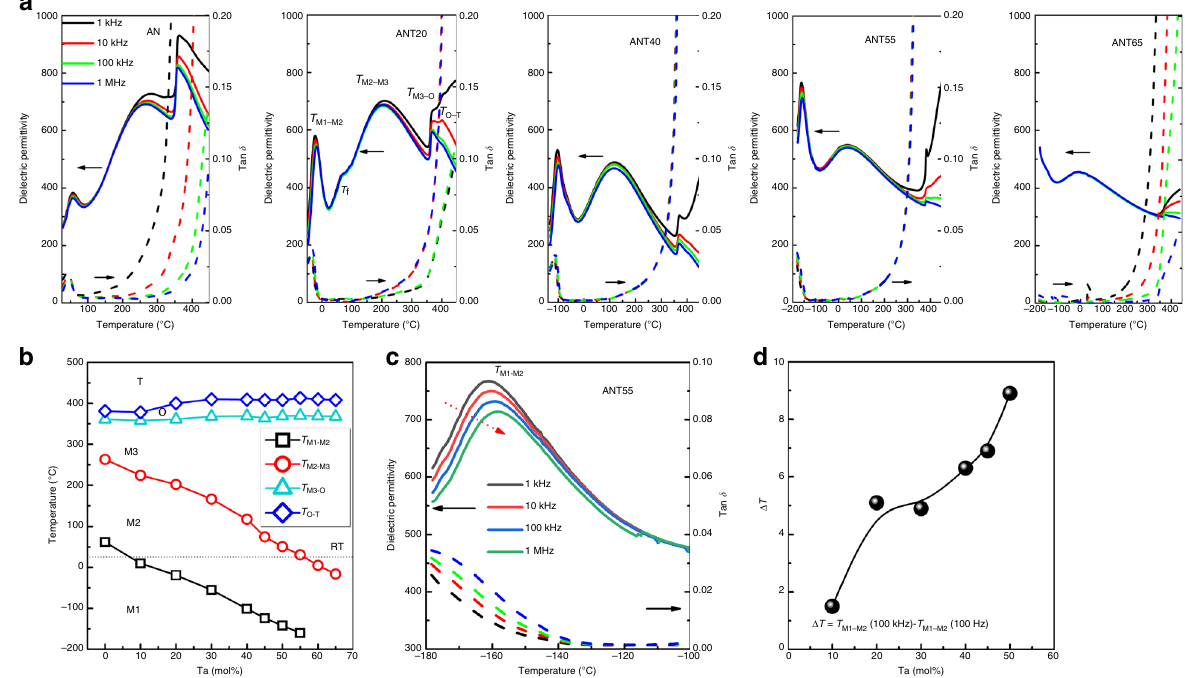
Fig. 2 Dielectric properties of ANT x ceramics. a Temperature- and frequency-dependent dielectric permittivity and loss. b Schematic phase diagram based on the temperature-dependent dielectric permittivity. c Dielectric permittivity and loss of ANT55 ceramic over the temperature range from − 180 to − 100 °C. d Composition dependence of the frequency dispersion △ T